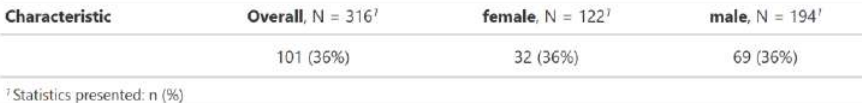
Table 24: Are you or anyone in your family beneficiary of the scholarship scheme from the Indian